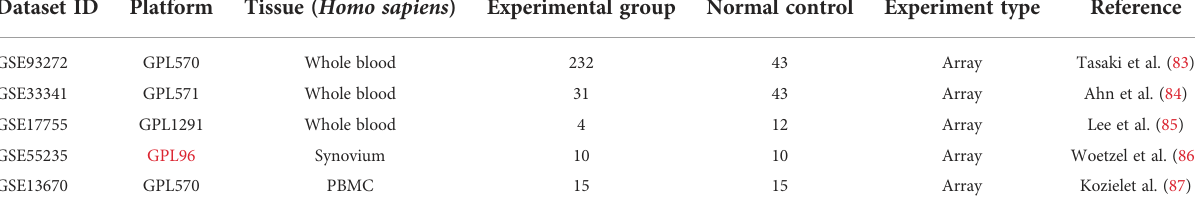
TABLE 1 Basic information of selected